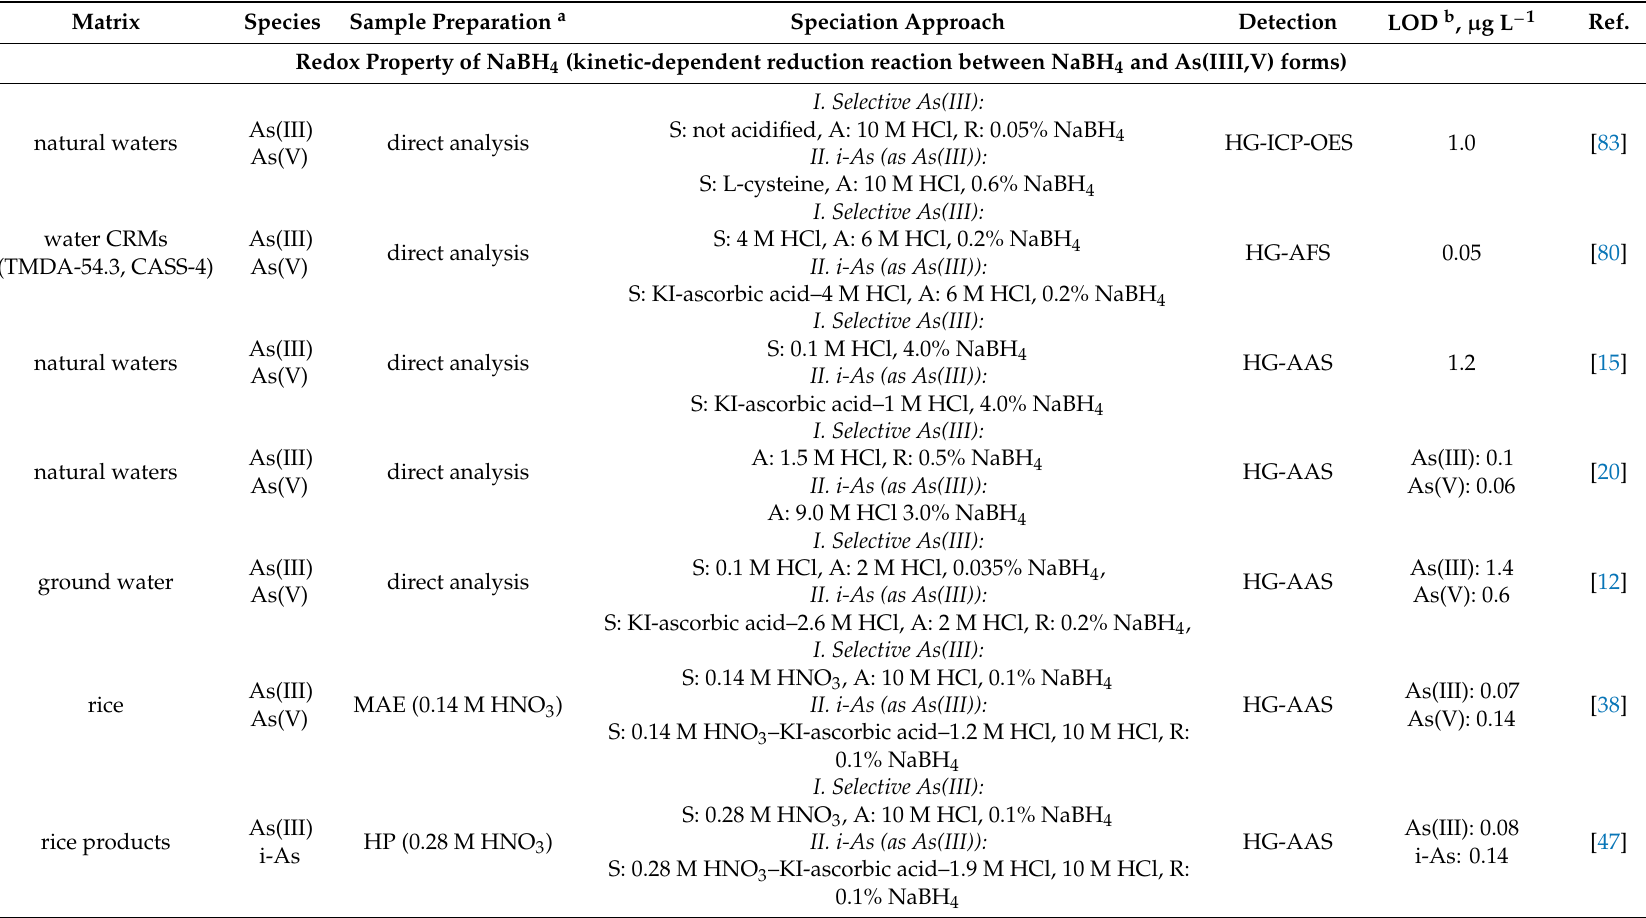
Table 2. Non-chromatographic procedures for individual speciation, i.e., selective determination of As(III) and